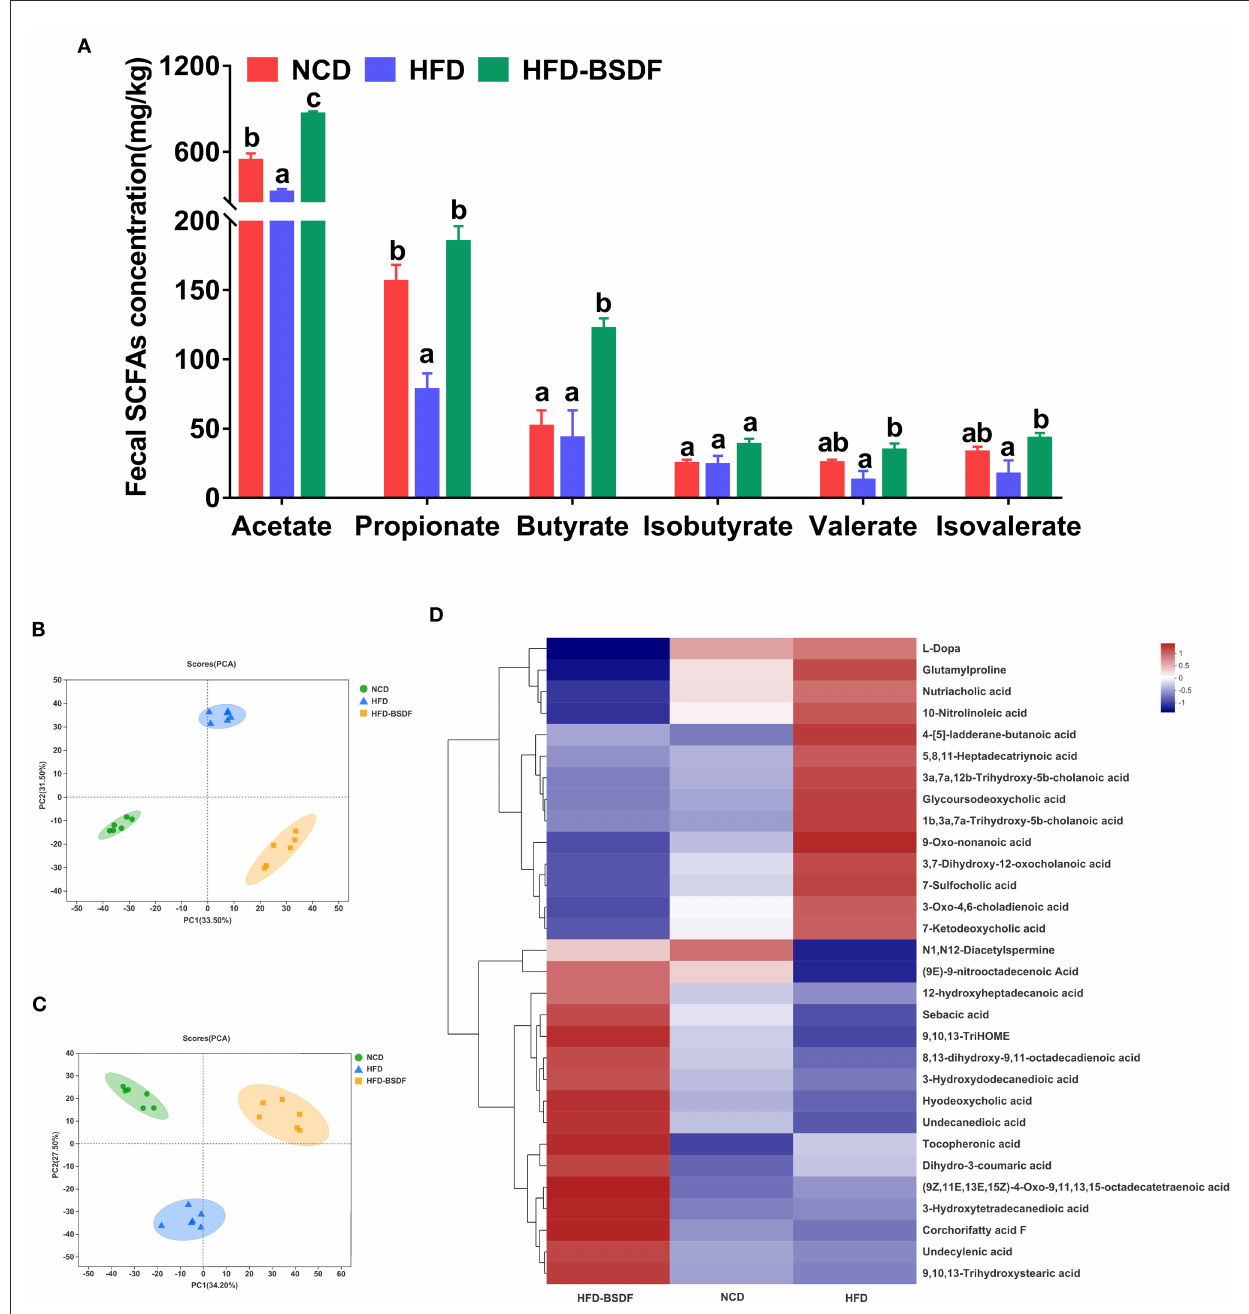
FIGURE5 Effects of BSDF administration on fecal short chain fatty acids (SCFAs) and metabolomics in HFD-induced obese mice. (A) Concentration of SCFAs. n = 8 per group. Principal component analysis (PCA) score plots of fecal metabolomic profiles in all treatment groups. (B) Positive ion, and (C) negative ion. (D) Hierarchical cluster analyses of differential metabolites. Red and blue of increasing intensity indicate up-regulation or down-regulation, respectively. n = 6 per group. NCD, normal control diet; HFD, high-fat diet; HFD-BSDF, high-fat diet supplemented with 6% BSDF freeze-dried